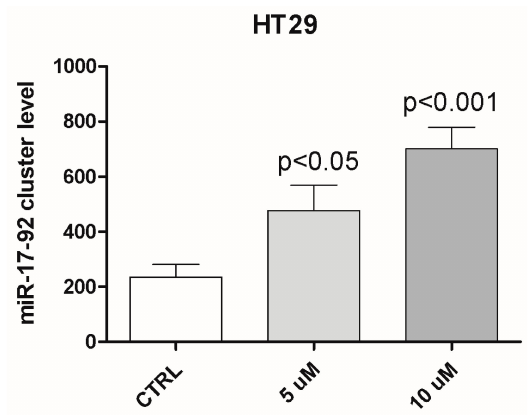
Figure A1. DAC treatment of HT29 cells determines an upregulation of the miR-17-92 cluster host gene. Table A1. PCA coordinates for the samples in